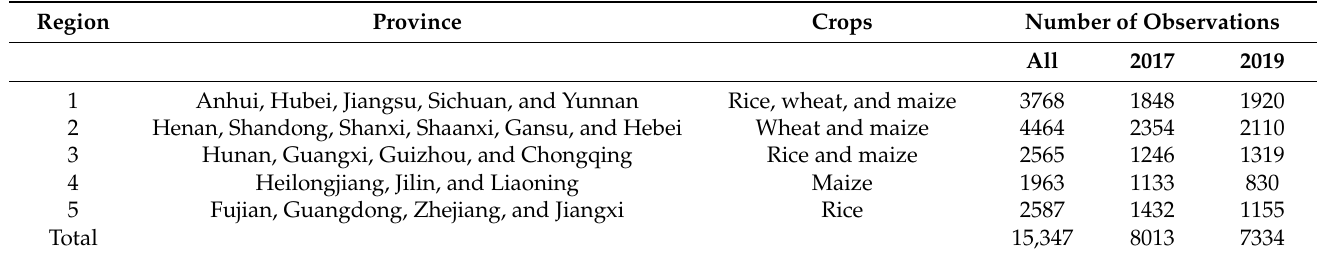
Table 1. Classification of Regions by their Main Staple Crops.